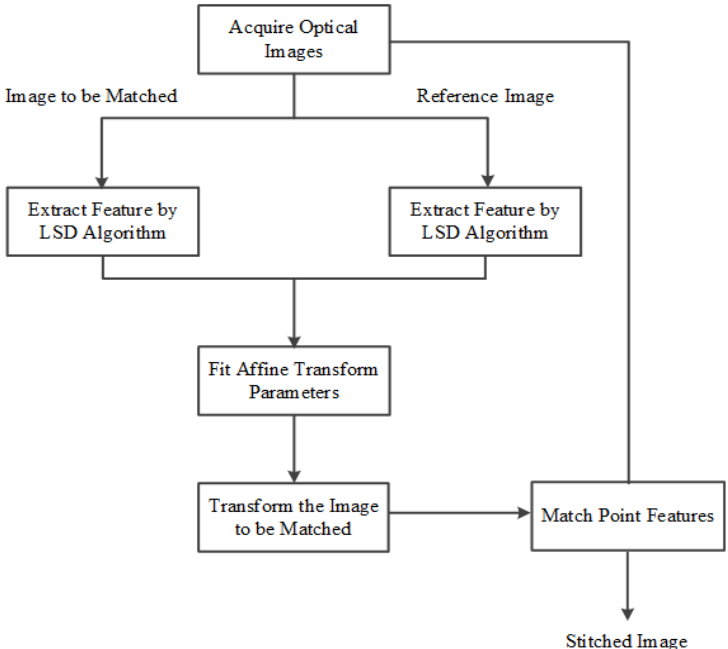
Figure 1. The proposed image registration algorithm flow chart.